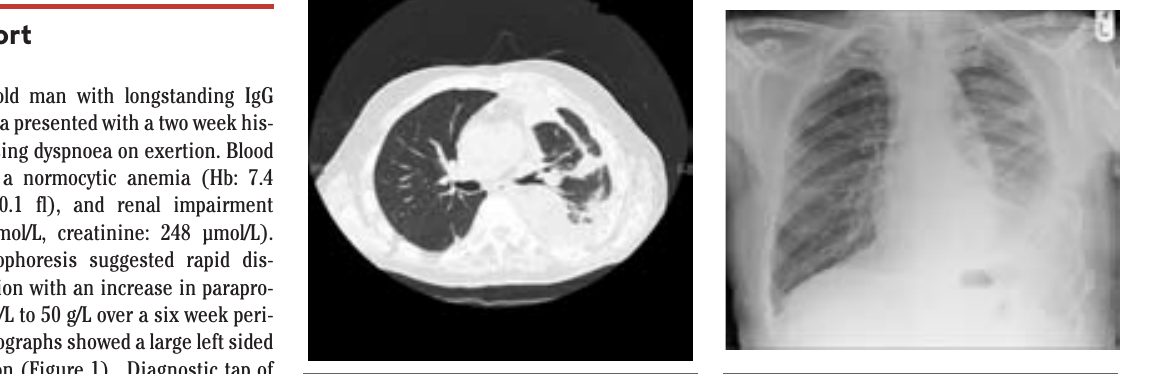
Figure 4. Repeat chest radiography taken seven days after starting treatment showed resolving pleural